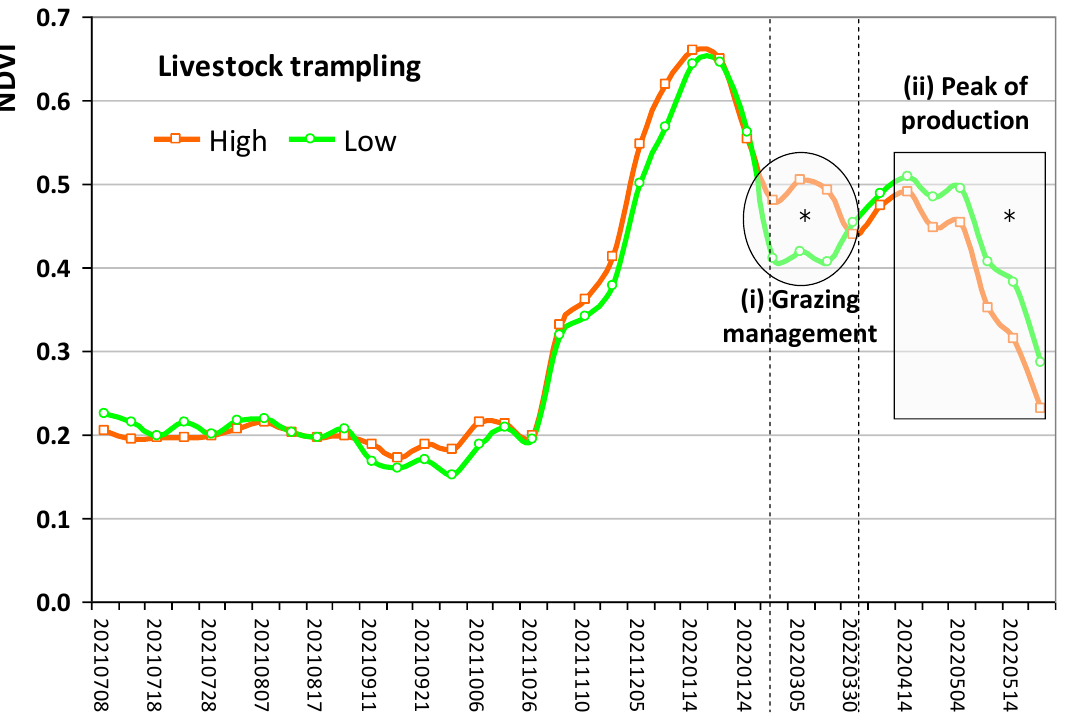
Figure 17. Mean Normalised Difference Vegetation Index (NDVI) time series obtained between July 2021 and June 2022 in high and low livestock trampling areas. *—Statistically significant at the 95% confidence level ( p < 0.05).